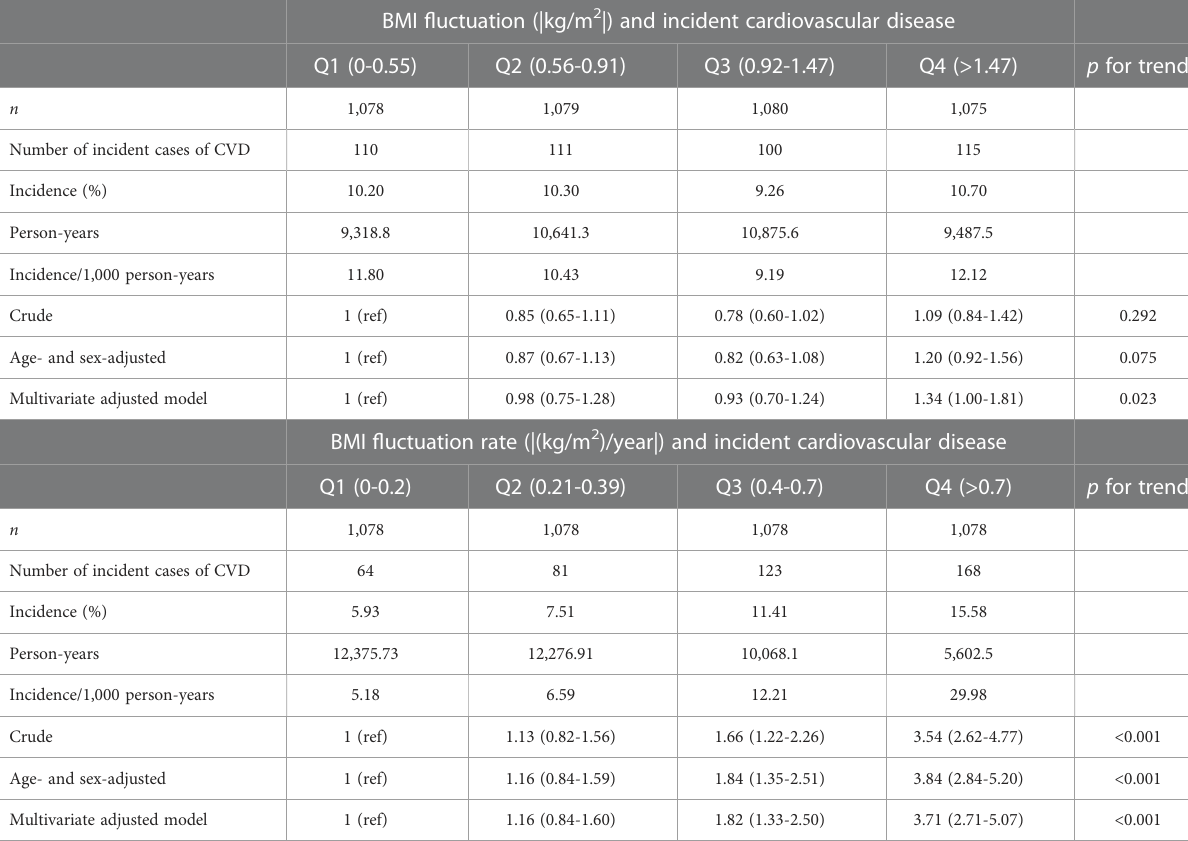
TABLE 2 Risk of incident cardiovascular disease (CVD) according to body mass index (BMI) fl uctuation (|kg/m 2 |) and BMI fl uctuation rate (|kg/m 2 / year|) of 4,312 participants drawn from the Vascular-Metabolic CUN clinical cohort between 1997 and